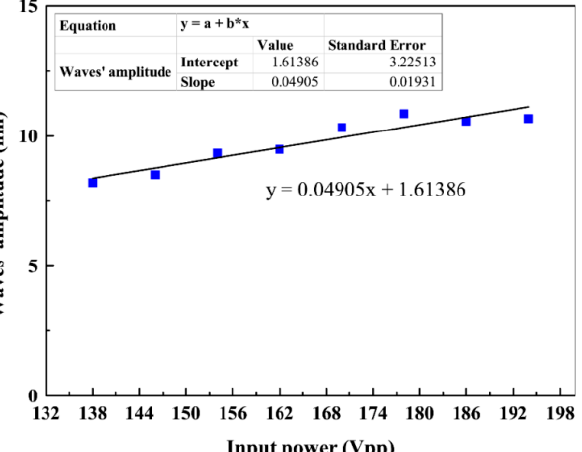
Figure 2. The linear relationship between the waves’ amplitudes and the peak to peak voltage on the SPT attached on the 1 mm mirror plate. In the function, * denotes the sign of multiplication.